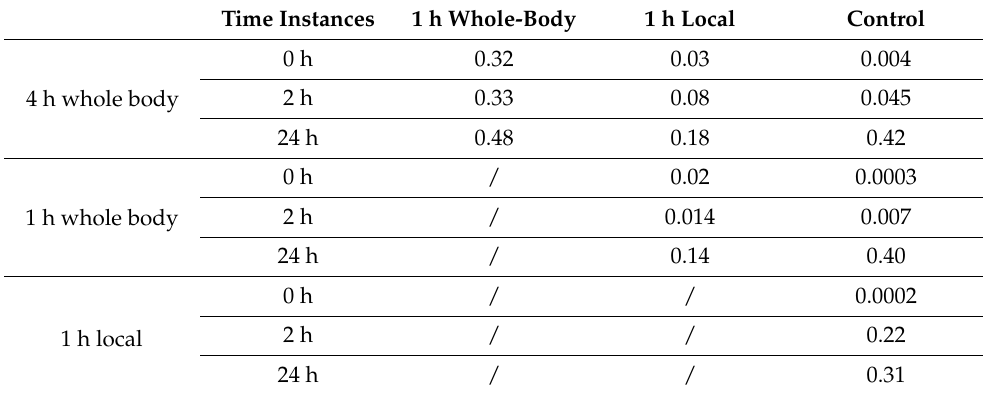
Table 1. Calculations of the p -value of the two specific groups using Student’s t -test for the normalized blood perfusion rates in the tumors. It should be noted that the comparison of the two groups was conducted at the same time instance, i.e., 0 h, 2 h, or 24 h post-heating. Time Instances 1 h Whole-Body 1 h Local Control 0 h 0.32 0.03 0.004 2 h 0.33 0.08 0.045 4 h whole body 24 h 0.48 0.18 0.42 0 h / 0.02 0.0003 2 h / 0.014 0.007 1 h whole body 24 h / 0.14 0.40 0 h / / 0.0002 2 h / / 0.22 1 h local 24 h / / 0.31